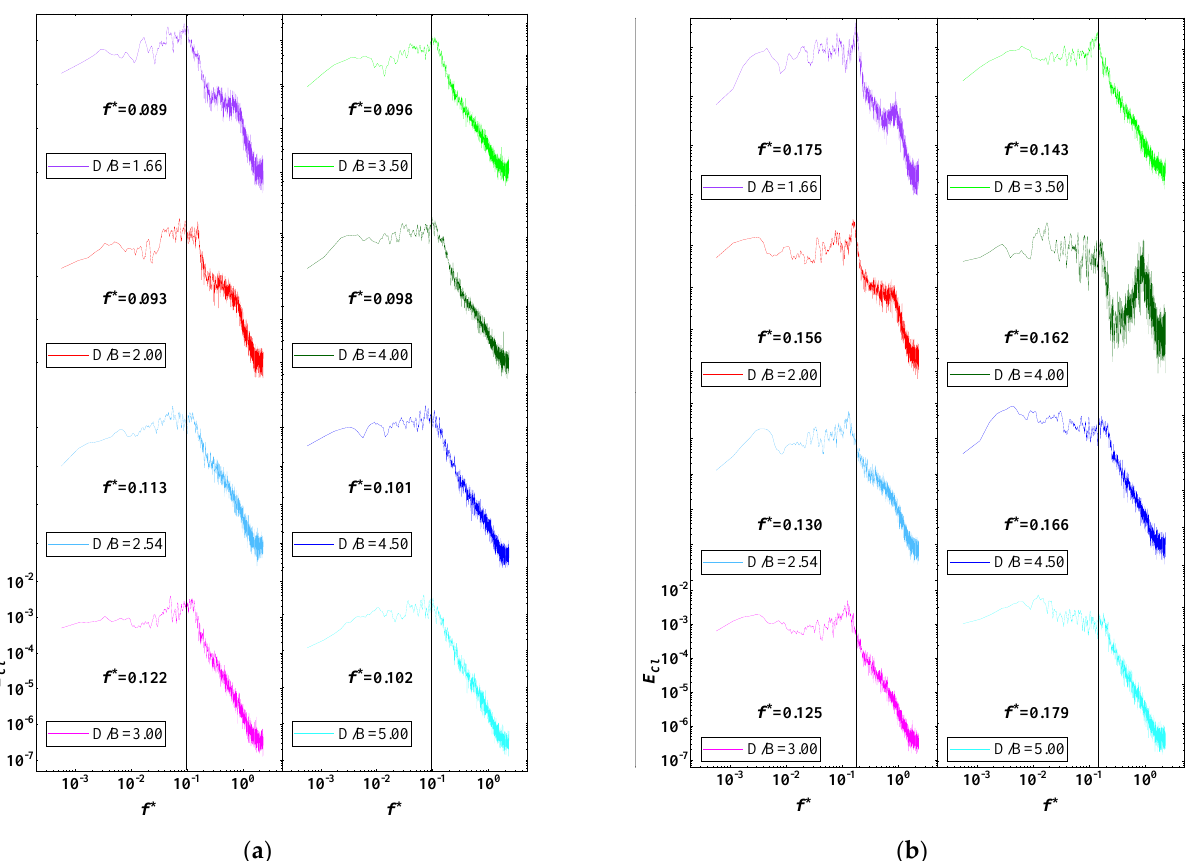
Figure 26. PSD of the lift coefficient for the downstream vehicle under the various D/B ratios investigated in Case 4: ( a ) Downstream vehicle; ( b ) Downstream bridge.